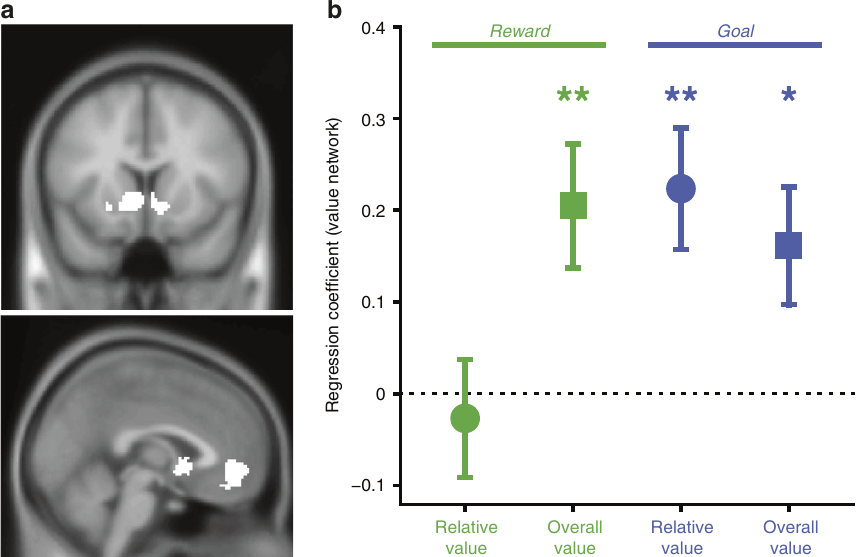
Fig. 2 The valuation network tracks goal values and overall, but not relative reward value. a Valuation network mask. b Mixed-effects regression coef fi cients show that the valuation network ROI de fi ned a priori based on ref. 15 . tracks both overall and relative goal value, and also tracks overall (but not relative) reward value. Error bars show standard error of the mean. * p < 0.05, ** p <